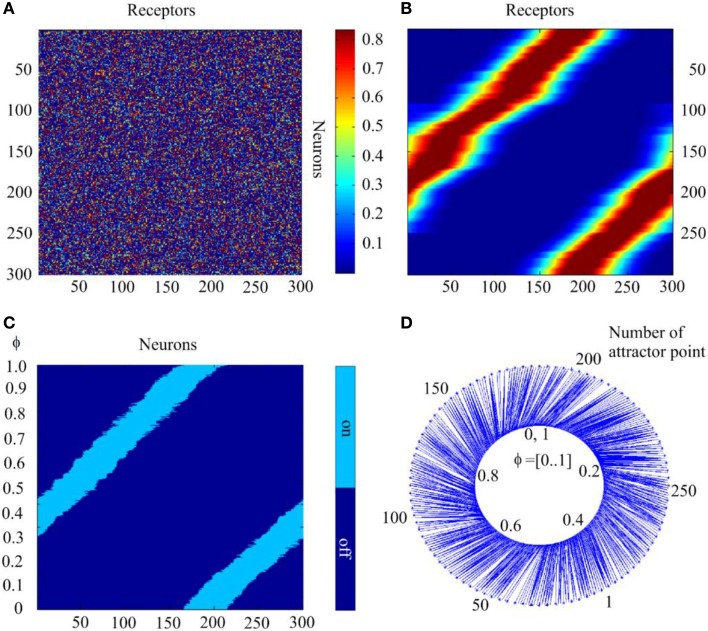
The self-organization of mapping from receptors to the attractor network. (A) Initial state of the matrix of the connections between the receptors and neurons of the attractor network. The value of matrix elements is color-coded. (B) The same matrix after completion of self-organization. (C) States of the network to which the activity of the network converges when the parameter of input signal takes 1000 sequential values in interval [0, 1.0]; abscissa—order # of neurons, ordinate—values of the parameter; light or dark blue colors denote excited or silent neurons. (D) Schematic mapping of the input signals to the states of the network. Inner circle, input signal parameter; outer circle, the attractor state order #; blue lines connect input signal representation points with the attractor points, to which neural network activity converges with the given input. The Figure demonstrates feasibility of SOM with neural attractors.